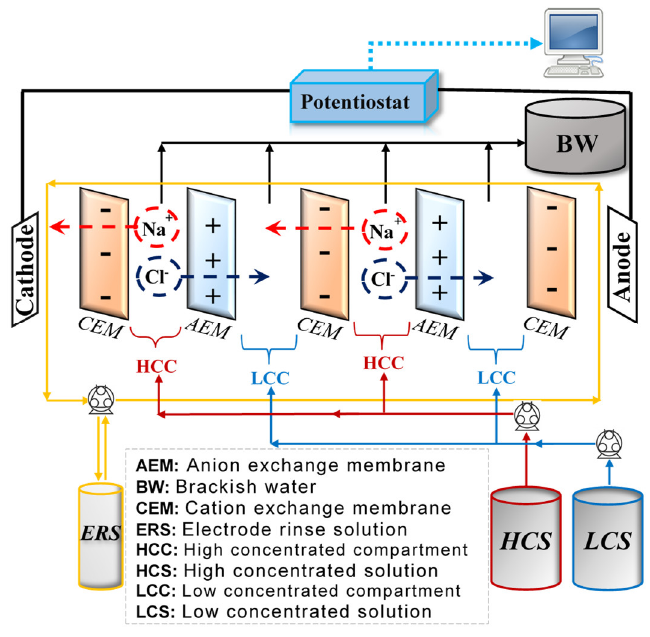
Figure 1. Detailed representation of the Reverse Electrodialysis (RED) process [14].